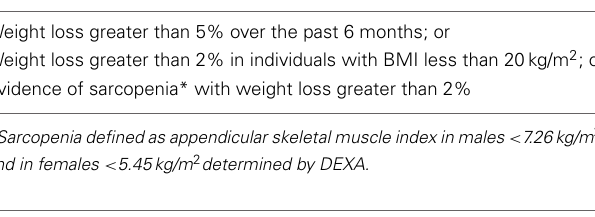
Table 2 | Assessment of cancer